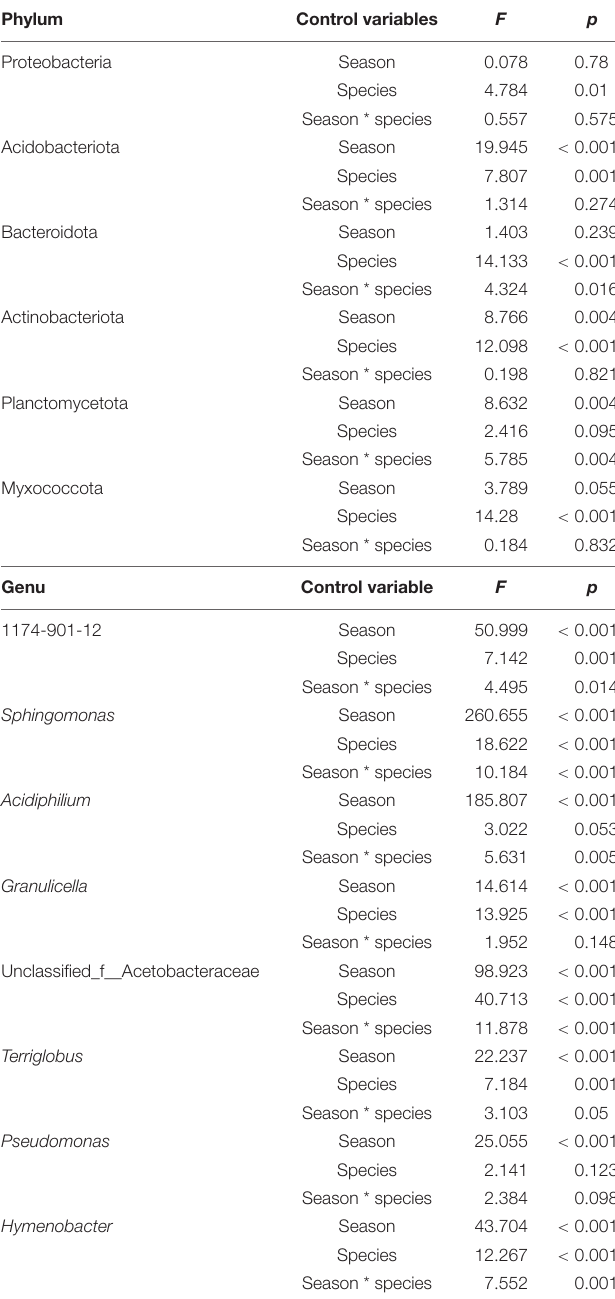
TABLE 2 | Two-way ANOVA (species × season) examining the differences in bacterial abundance between dominant bacteria abundance at both phylum and genus